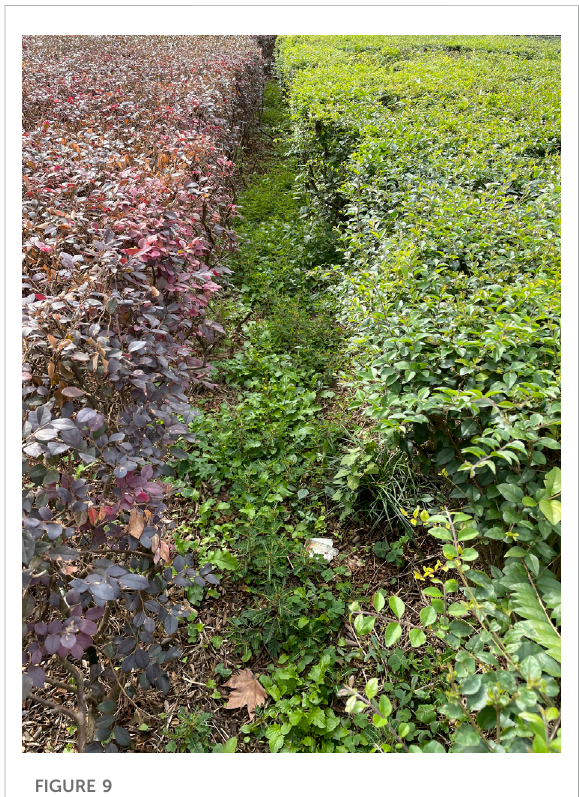
FIGURE 9 Abundant spontaneous vegetation under pruned shrubs.